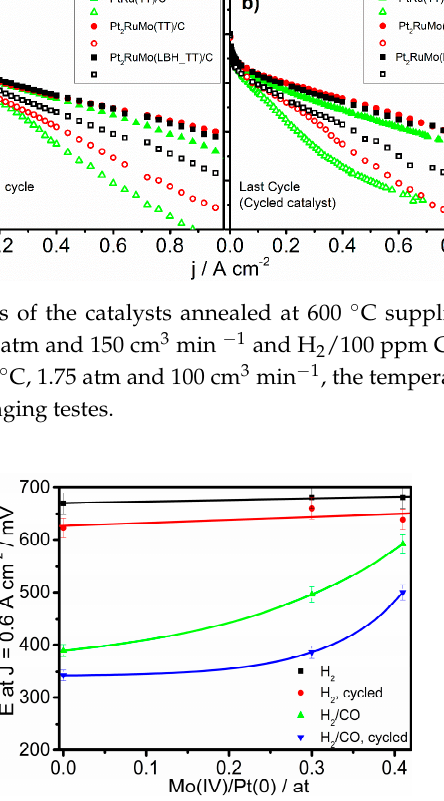
Figure 6. Dependence of the hydrogen oxidation reaction (HOR) and HOR/CO activity, expressed as the current density at 0.6 V, on the Mo(IV)/Pt(0) atomic ratio.